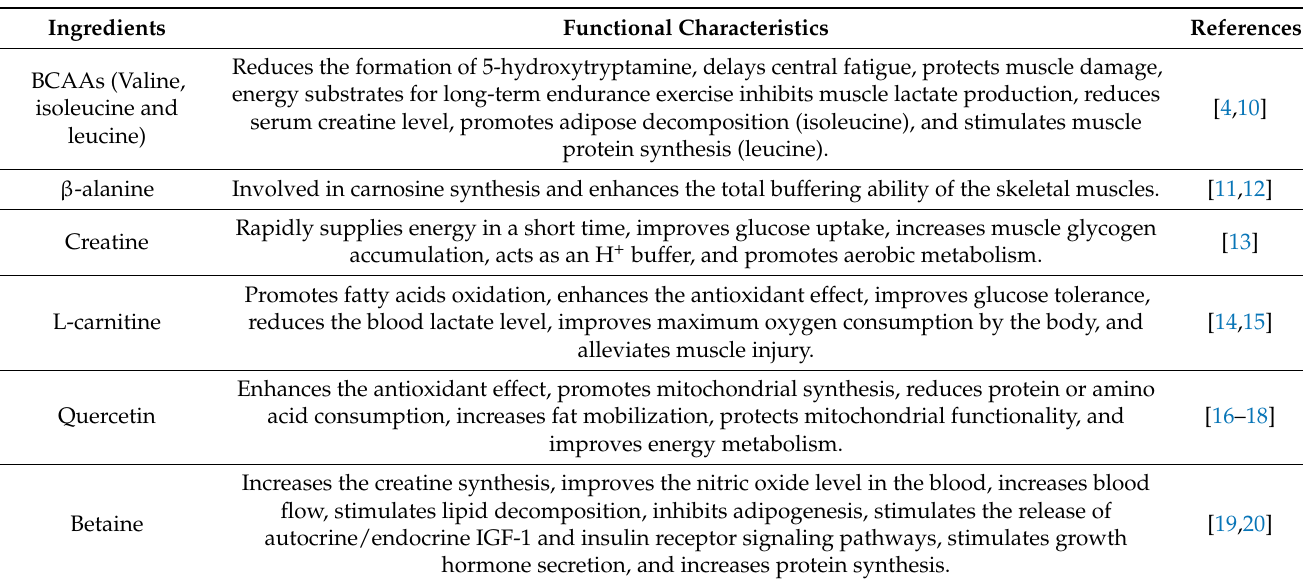
Table 1. Functional characteristics of the ingredients in the formula supplement. Ingredients Functional